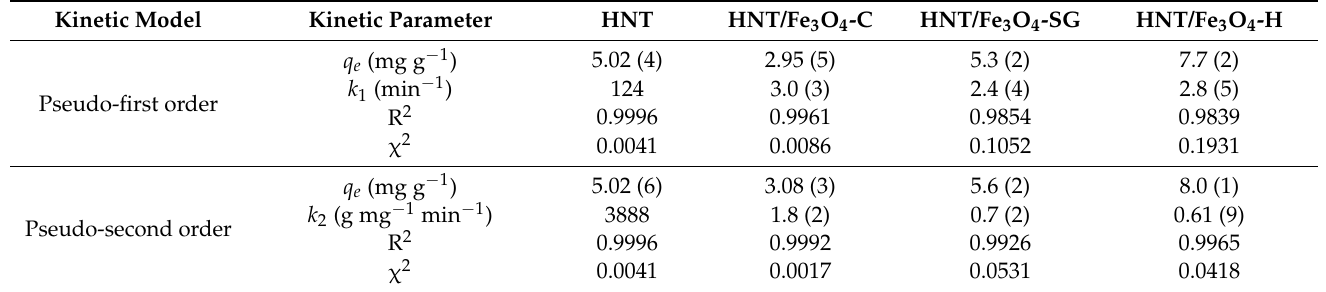
Figure 8. Kinetic profiles (pseudo-first-order (—), pseudo-second-order (…)) for OFL onto HNT ( ■ black), HNT/Fe 3 O 4 -C ( ⬤ red), HNT/Fe 3 O 4 -H ( ▲ blue) and HNT/Fe 3 O 4 -SG ( ▼ green) (Experimental conditions: sorbent 20 mg, 10 mL tap water, OFL initial concentration 20 mg L − 1 , RSD < 10%). The calculated kinetic parameters are shown in Table 5. Table 5. Kinetic parameters for OFL adsorption onto HNT, HNT/Fe 3 O 4 -C, HNT/Fe 3 O 4 -H, and HNT/Fe 3 O 4 -SG.